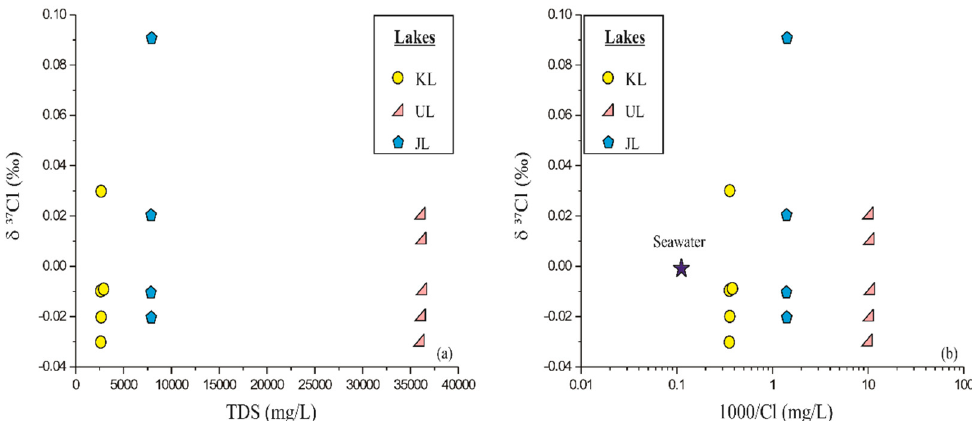
Figure 7. δ 37 Cl variations with ( a ) TDS and ( b ) 1 / Cl in the saline lakes of the Salt Range area.